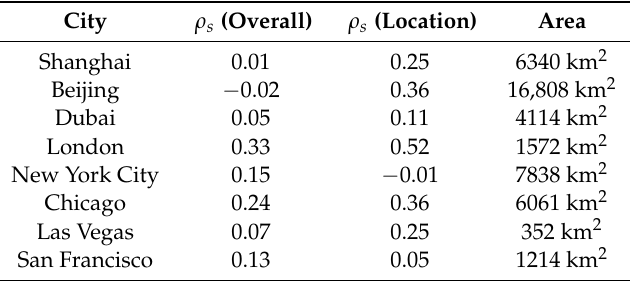
Table 2. Spearman correlation analysis between latent-space similarity and overall/location ratings. City ρ s